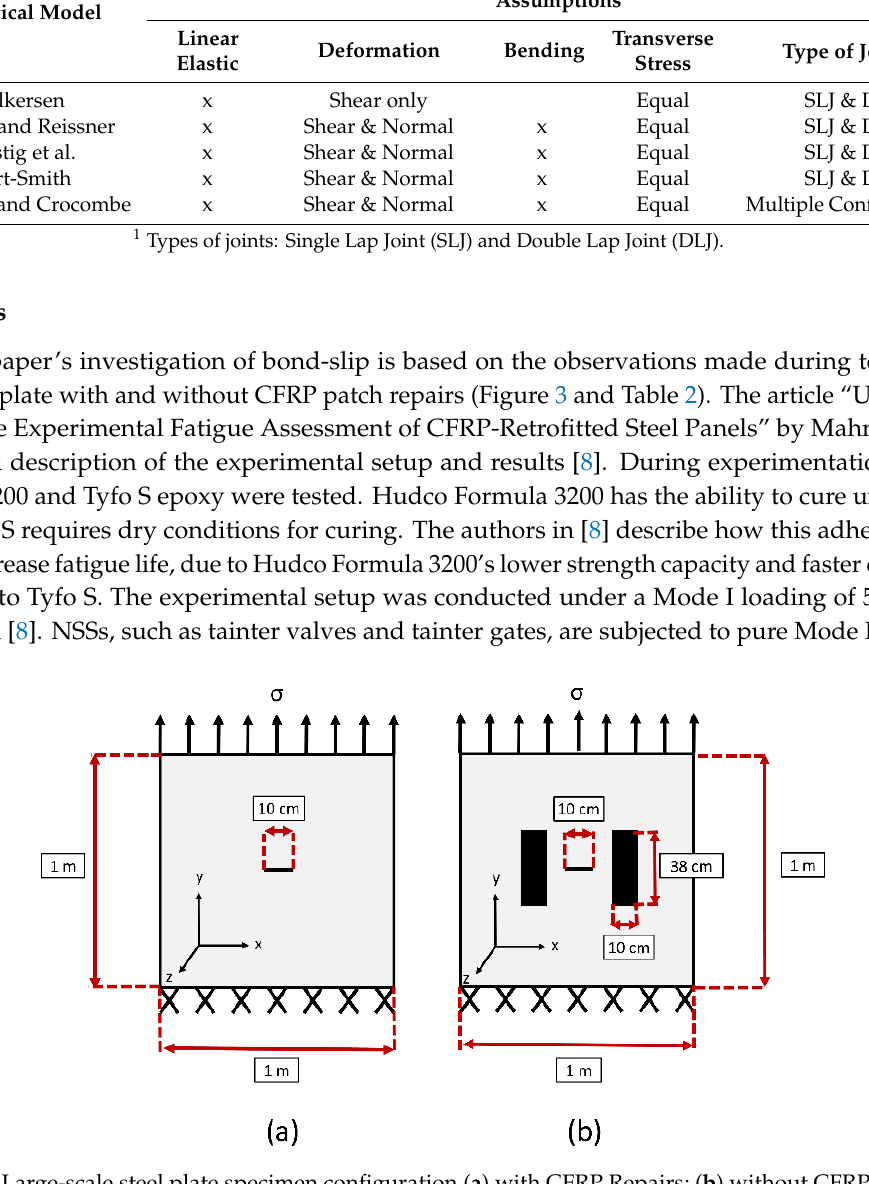
Table 1. Summary of common bond shear analytical models and their common assumptions [21].